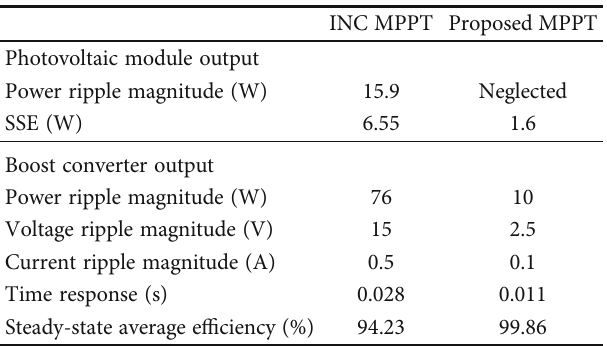
Table 2: Comparison of the STC simulation results of the proposed MPPT and INC MPPT schemes.